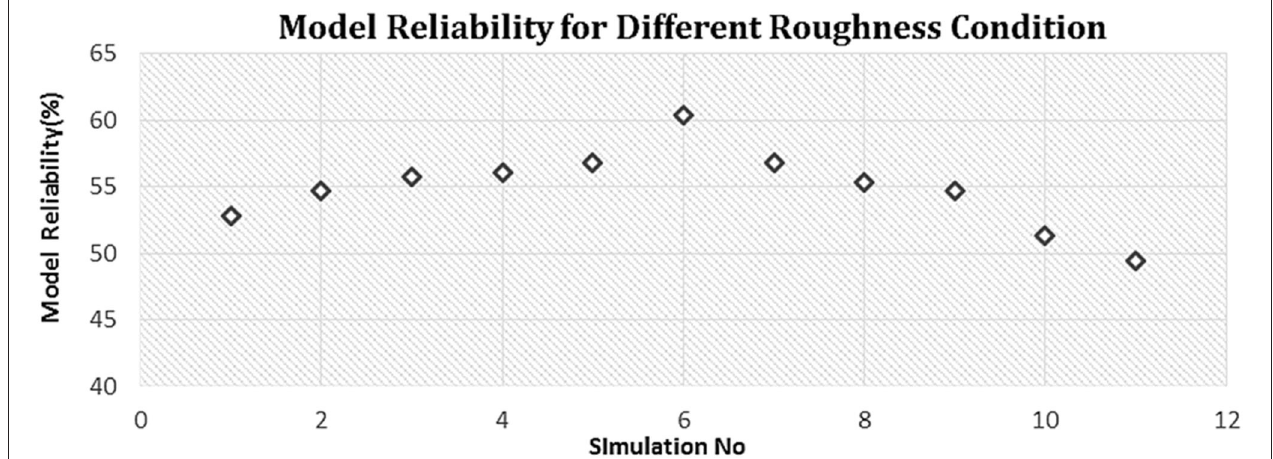
FIGURE 3 | Performance of the hydrodynamic model with different roughness